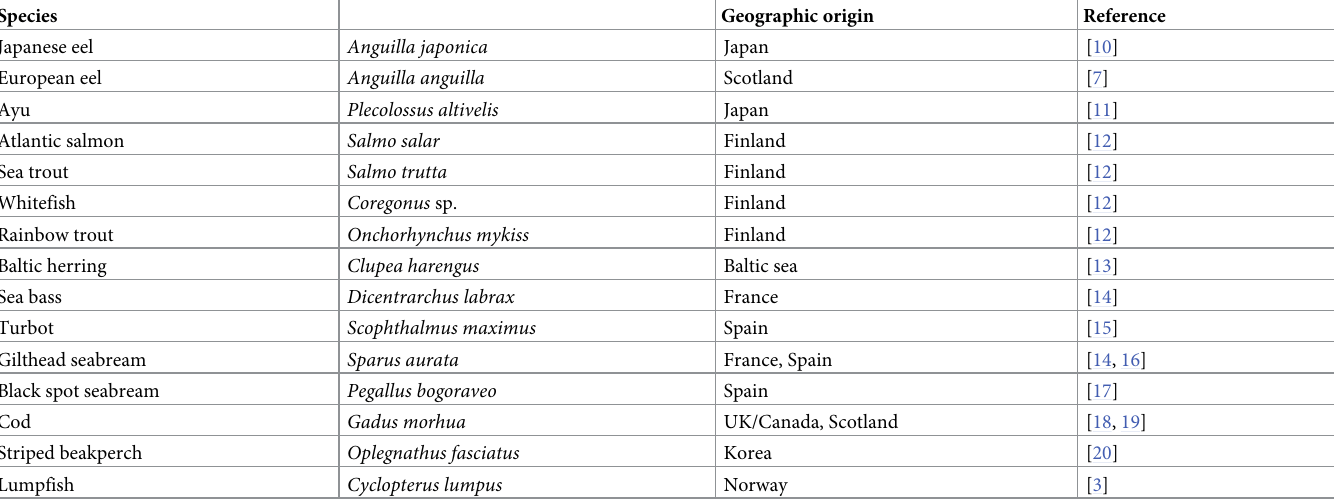
Table 1. Species of wild caught and cultured fish shown to develop disease due to infections with P . anguilliseptica